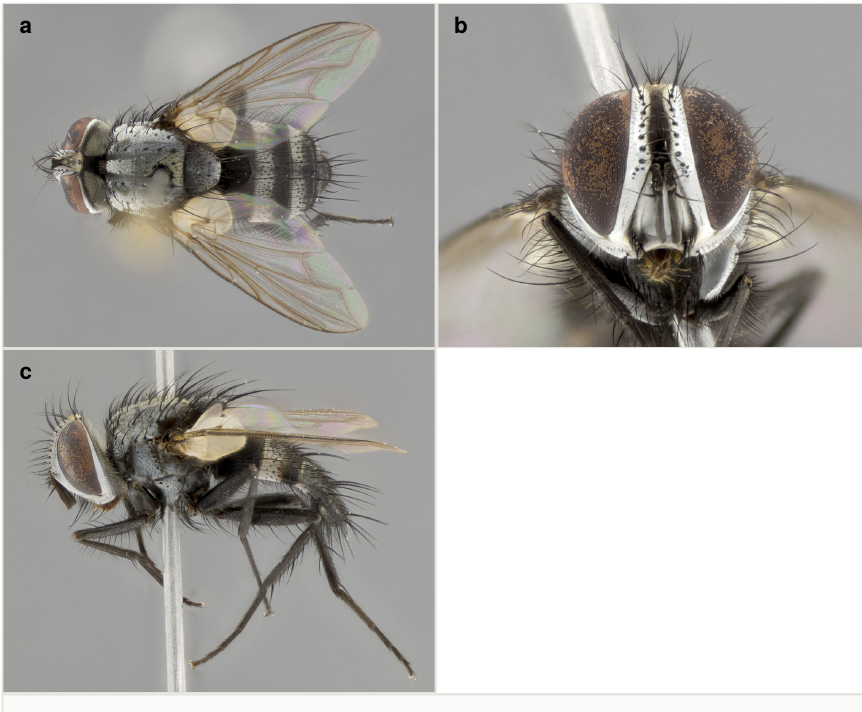
Figure 2. Vibrissina albopicta (Bigot, 1889). a–c : ACG male, voucher code